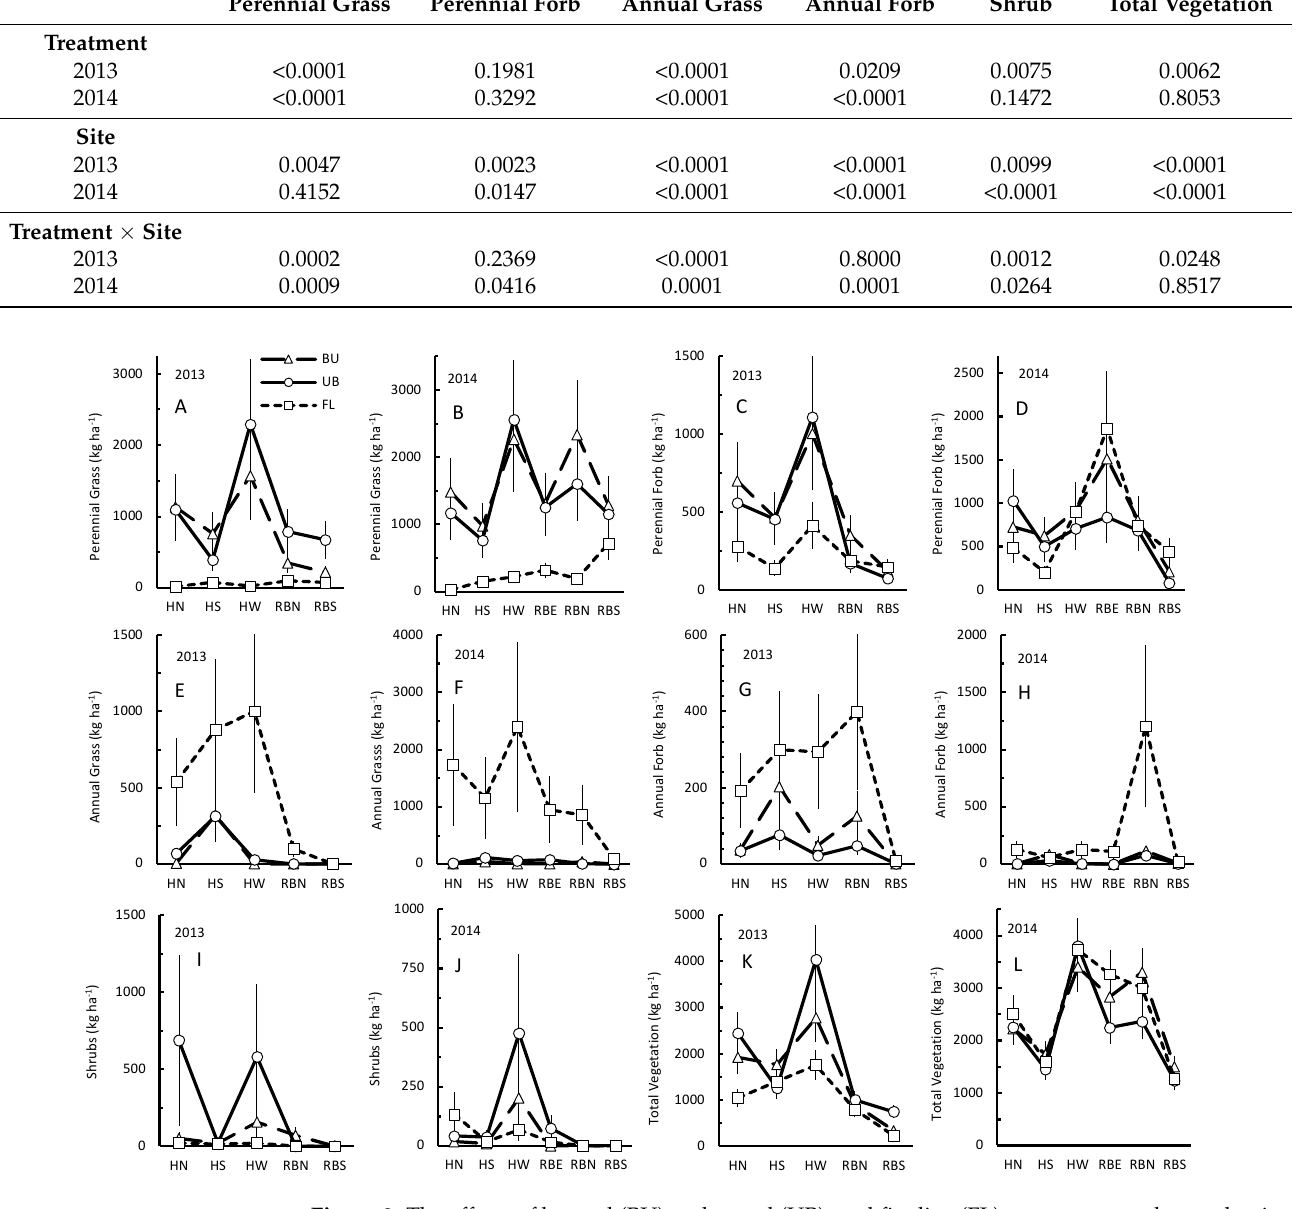
Figure 2. The effects of burned (BU), unburned (UB), and fire line (FL) treatments on the production (kg/ha) of perennial grass, perennial forb, annual grass, annual forb, shrub, and total vegetation in 2013 and 2014. Sites are represented on the x -axis and symbols and lines are treatment-estimated marginal means within sites. Error bars are ± se. Individual panels of response and year combinations are identified by letter ( A – L ). Although not continuous data, lines between points display the interaction between treatments and sites.